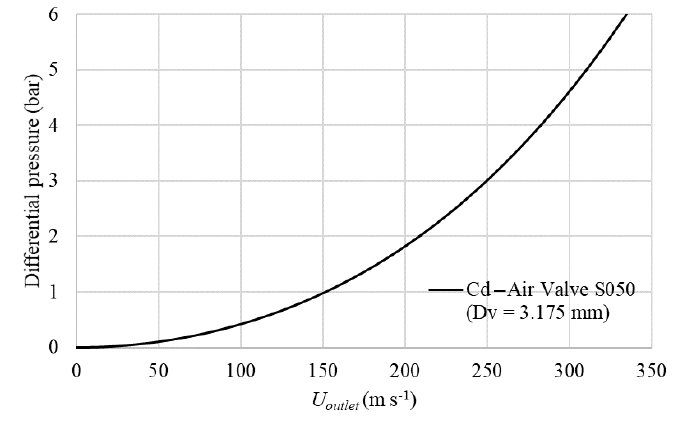
Figure 1. Characteristic outflow discharge coefficient in air valve S050.